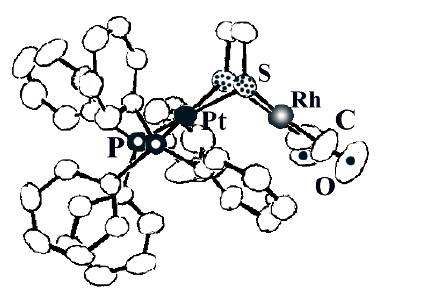
Figure 9. Structure of [(Ph